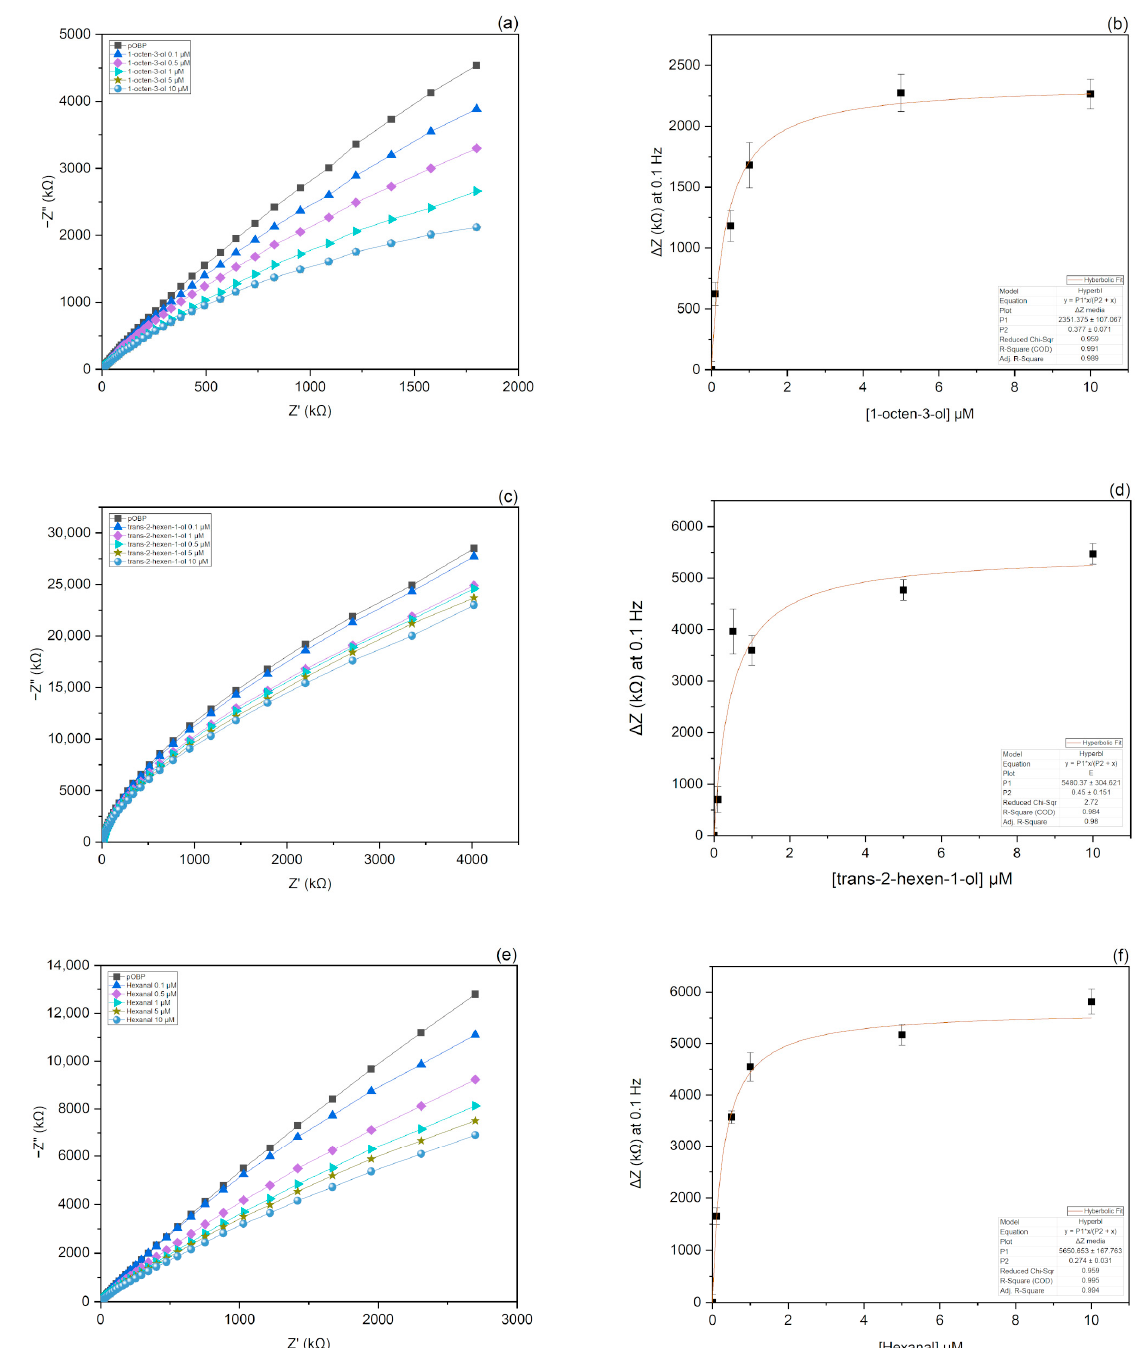
Figure 5. Nyquist plots and binding curves fitting of 1-octen-3-ol, trans-2-hexen-1-ol, and hexanal. Nyquist plots represent the impedance response of the biosensor to increasing concentrations of 1-octen-3-ol ( a ), trans-2-hexen-1-ol ( c ), and hexanal ( e ). As a consequence of the binding events at the interface, the impedance of the electrochemical system increases at increasing concentrations of the VOC samples. Binding curves were obtained by plotting the change in impedance at 0.1 Hz as a function of 1-octen-3-ol ( b ), trans-2-hexen-1-ol ( d ), and hexanal ( f ) concentration. The fitting curves, obtained by a non-linear function, are highlighted in red color.